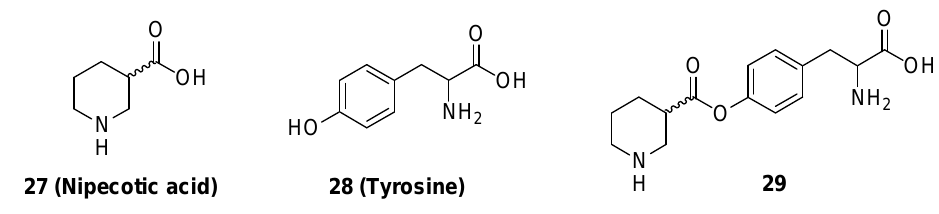
Figure 10. Chemical structures of nipecotic acid, tyrosine and their ester. Nipecotic acid shows anticonvulsant activity only when administered as the